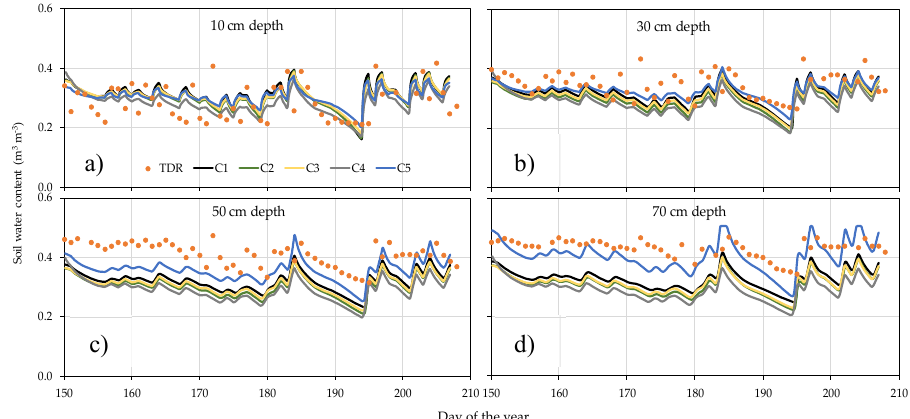
Figure 7. Comparison between measured (TDR) and simulated soil water content with the five approaches at five depths (from a to d ) after inserting the impervious layer as specified in the text.